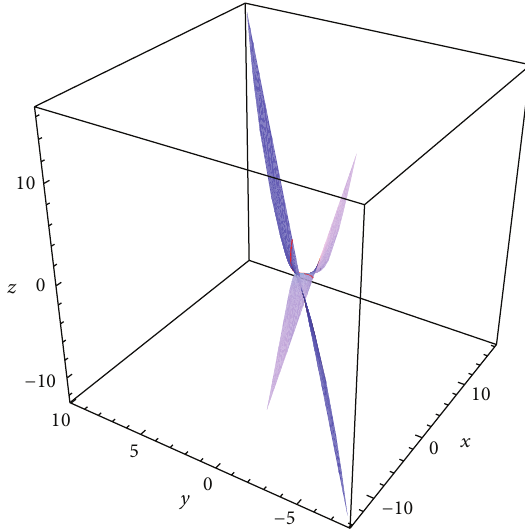
Figure 3: A member of surface family for 𝛾 = 1 and 𝛿 = cosh 𝑠 and the curve 𝛼